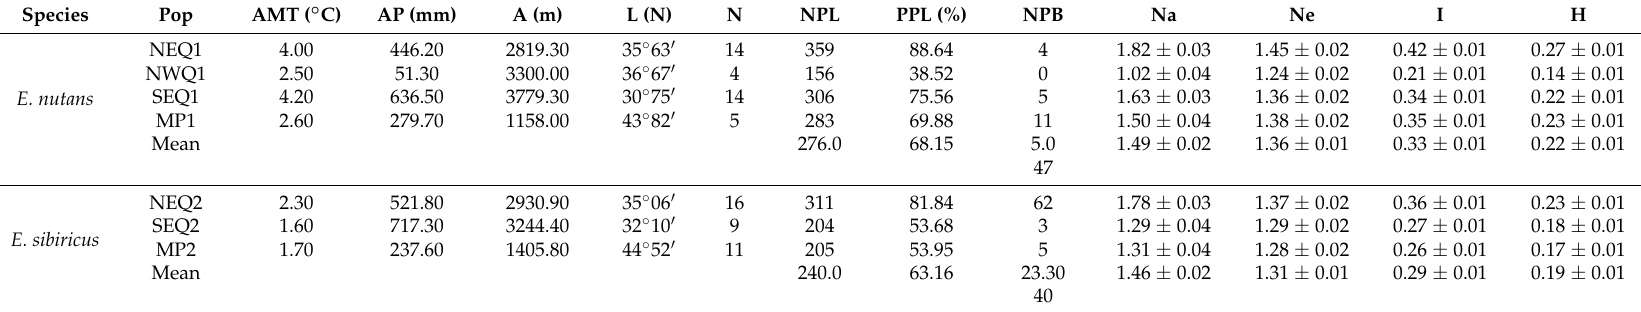
Table 3. Environmental parameters of geographic regions and genetic variability within four E. nutans and three E. sibiricus groups.